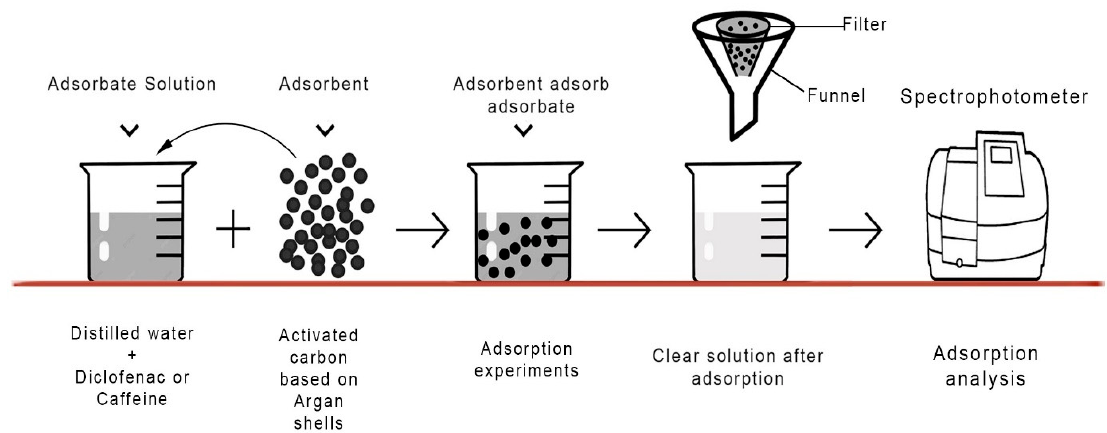
Figure 2. Adsorption process.